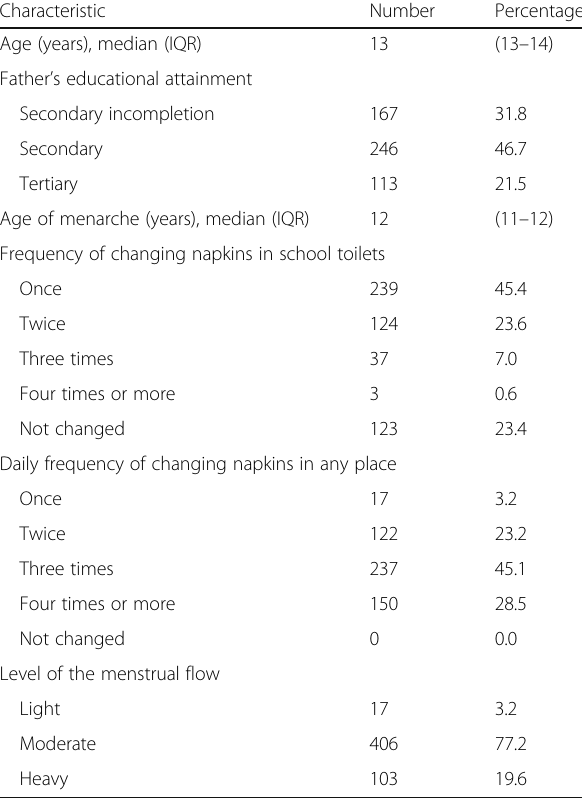
Table 1 Socio-economic and menstrual hygiene characteristics of respondents ( n =